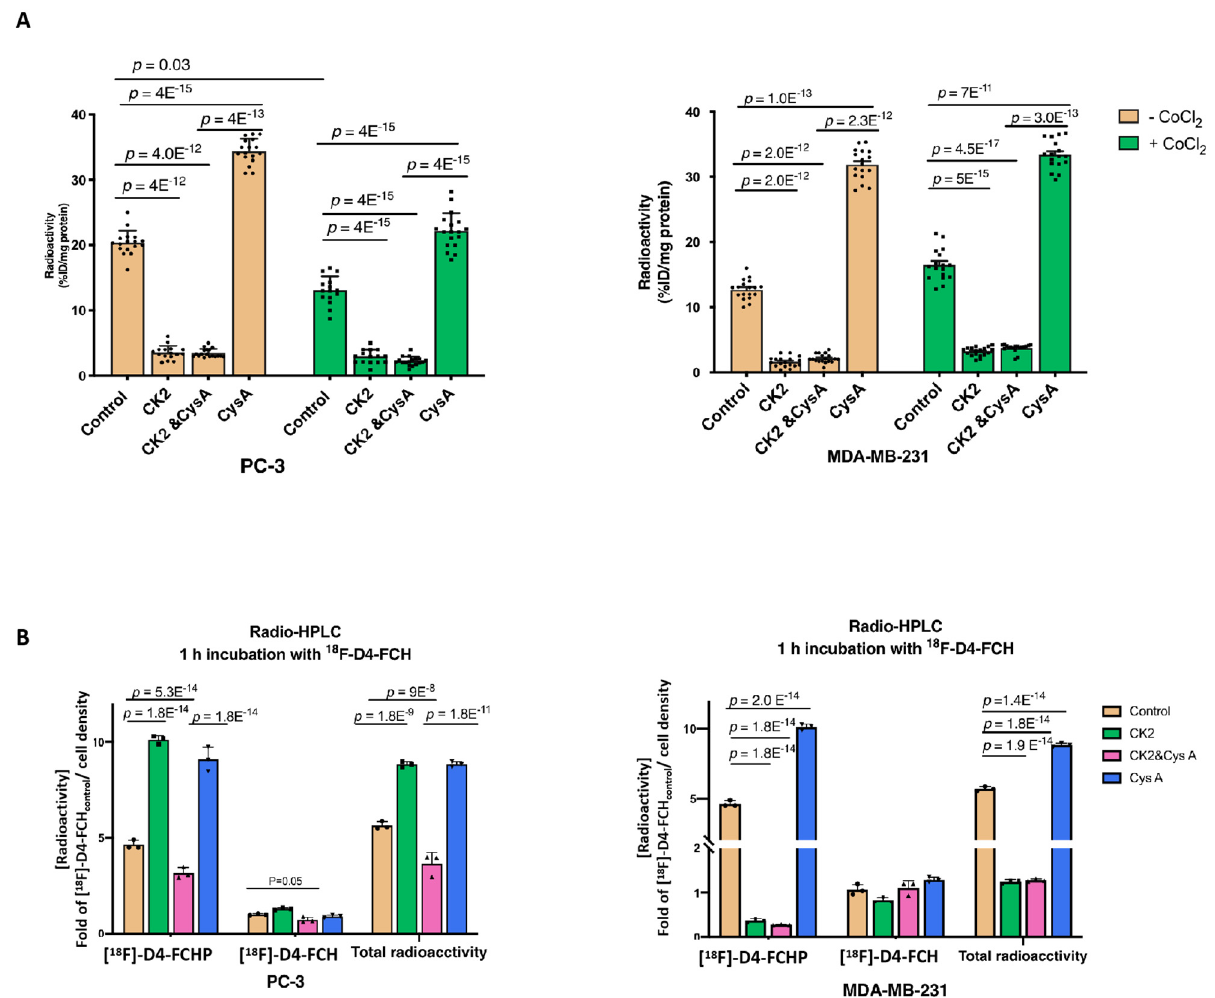
Figure 5. [ 18 F]-D4-FCHP featured as a preferable substrate for the efflux system. ( A ) The standard 1-h 18 F-D4-FCH uptake assay for cells pretreated with CoCl 2 for 24 h. The Cys A-treated cells were pre-treated with 10 µM cys A for 24 h and then incubated with cys A and 0.37 MBq [ 18 F]-D4-FCH for 1 h. Three independent sets of six repeats for each condition ( n = 18) were carried out. A two-way ANOVA with Tukey’s multiple comparison tests were carried out. ( B ) A summary of the radiolabelled choline species. The dominant radiolabelled choline species [ 18 F]-D4-FCH] determines the [ 18 F]-D4-FCH uptake. The cells were pretreated with 10 µM CK2, 200 µM CoCl 2 , or 10 µM cys A for 24 h and then incubated with 0.37 MBq [ 18 F]-D4-FCH for 1 h. The data are the mean ± standard deviation for three independent repeats ( n = 3). A one-way ANOVA with Tukey’s multiple comparison tests were carried out.